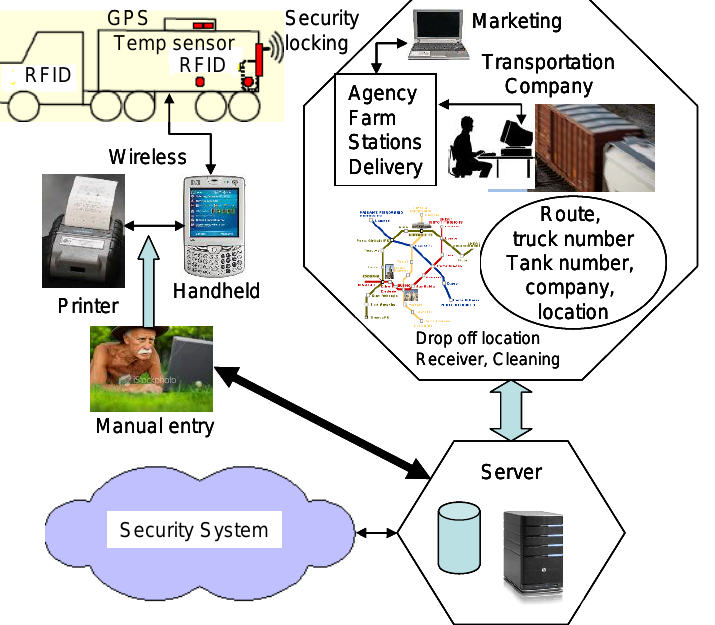
Figure 3. A model for a secure supply chain transportation